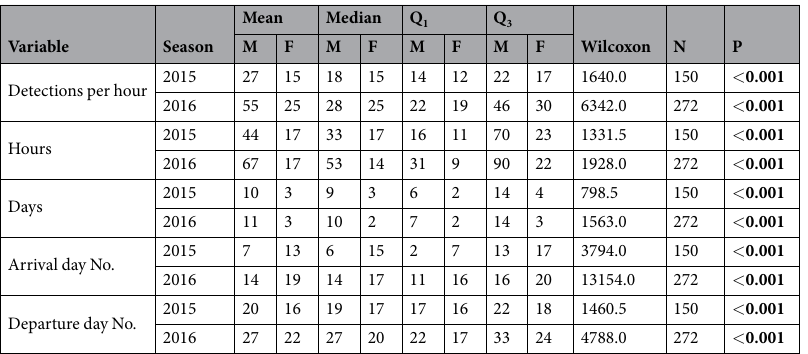
Table 1. Summary of movement at the spawning ground, seasonal protandry and times of leaving in the 2015 and 2016 seasons. Mean values, medians, first (Q 1 ) and third quartiles (Q 3 ), values from the one-sided Wilcoxon rank-sum test, sample sizes (N) and p-values are presented in the table. Significant p-values are given in